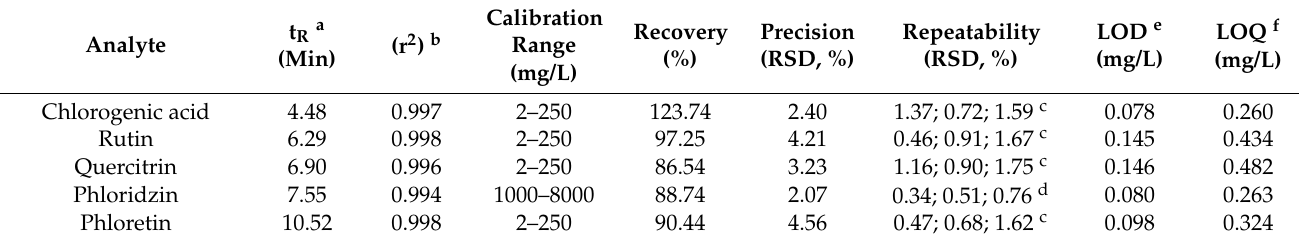
Table 1. Validation parameters of individual analytes using YMC Triart C18 ExRS (150 × 4.6 mm, particle size 5 µ m) column.